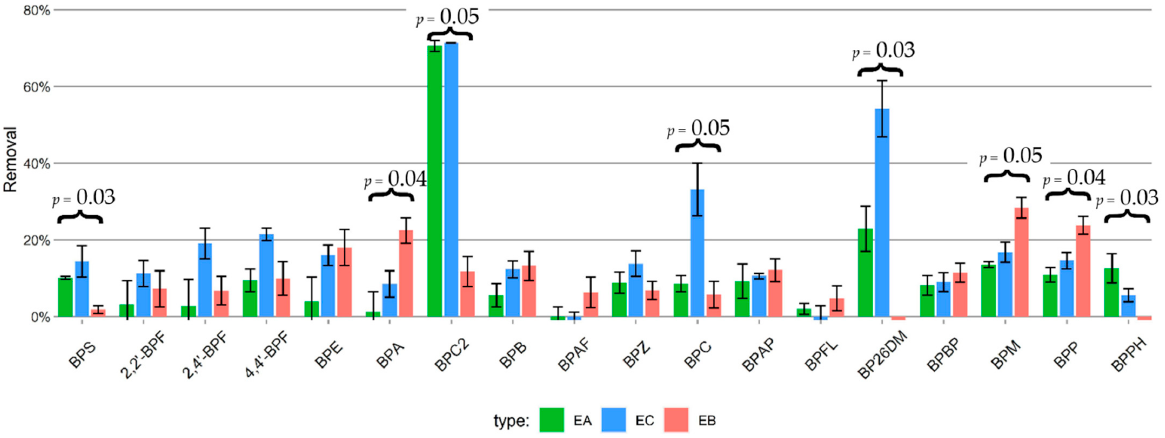
Figure 6. Biotic removal of BPs in axenic microalgae (EA), co-cultures (EC) and bacterial cultures (EB) 168 h after addition of BPs to the medium ( n = 3 for each group). Significant differences are denoted by p -value of the Kruskal–Wallis test. Compounds are arranged from lowest (BPS, log P = 2.3) to highest (BPPH, log P = 7.3) log P value. Overall biotic removal (combined removal of all BPs) was, on average (white squares, Figure 7), highest in the co-culture (18 ± 18%), followed by the axenic culture (11 ± 15%) and lastly, the bacterial culture (10 ± 9%); however, differences between the three cultures series were not statistically significant ( p > 0.05). The large standard deviations result from the broader range of biotic removal values of individual compounds. Figure 7. Overall biotic removal of all 18 BPs in axenic microalgae (EA), co-cultures (EC) and bacte- rial cultures (EB) 168 h after addition of BPs to the medium ( n = 18 for each group). Boxplot ex- plained: thick horizontal line is the median, box spans from the first to the third quartile, whereas whiskers span 1.5 interquartile range. White square is the mean of all observations. Points repre- senting the removal of individual compounds are also shown to observe their distribution easier.